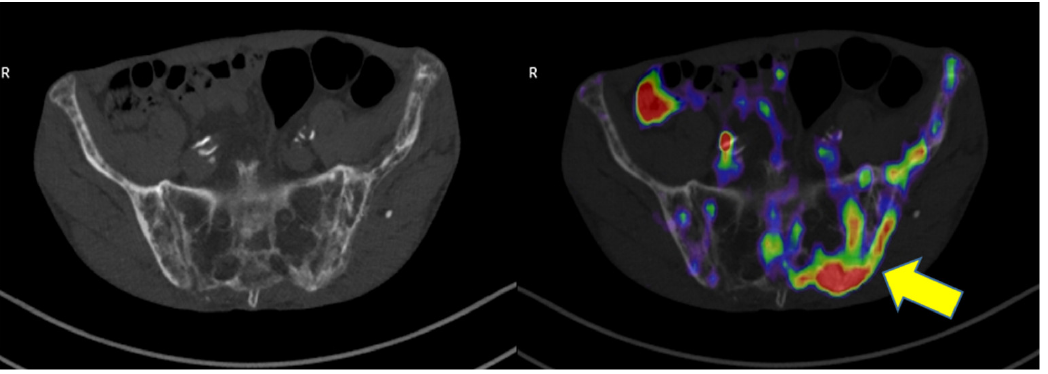
Figure 1. An example of Paget disease in CT (on the left ) with increased [ 18 F]FDG uptake (yellow arrow) at PET/CT (on the right ).